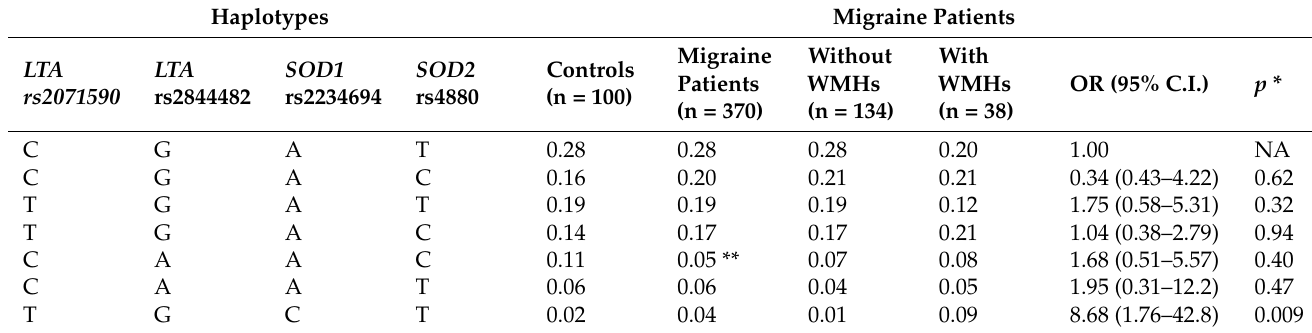
Table 3. Lymphotoxin alpha ( LTA ) and superoxide dismutase 1 ( SOD1 ) and 2 ( SOD2 ) haplotype analysis and corresponding frequencies in 370 migraine patients and 100 control